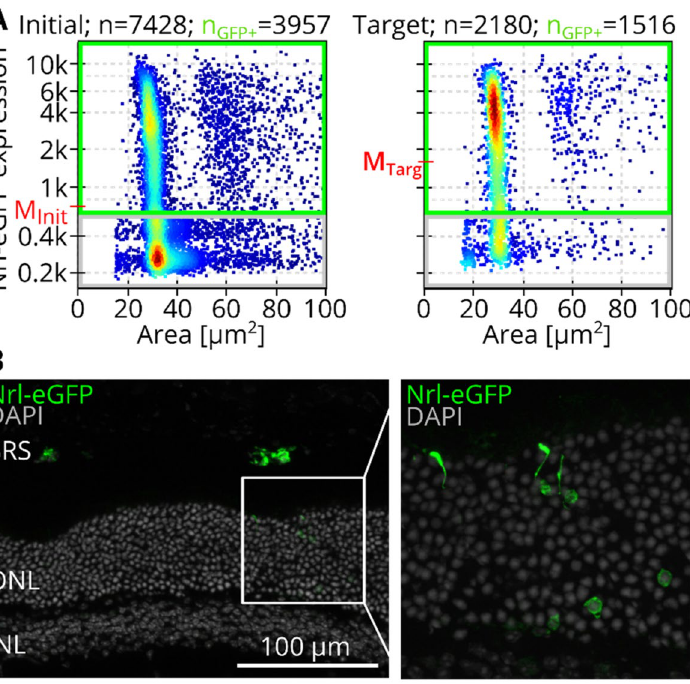
Figure 7. Label-free photoreceptor sorting of dissociated Nrl-eGFP mouse retina cells & transplantation. ( A ) Scatterplots show RT-FDC measurements of the initial sample and the target sample after label-free sorting. The axes show the area and fluorescence expression and the color code represents the density of events. The median fluorescence expressions are given as M Init (= 728) and M Targ (= 1,684). The gating strategy for selection of GFP + events is indicated by a green rectangle, resulting in 53.2% and 69.5% GFP + cells in the initial and target sample, respectively. ( B ) Immunofluorescence images showing sorted GFP + cells in the murine SRS, two weeks after transplantation. GFP + cell bodies and segments can be found in the host ONL (magnification), likely as a result of cytoplasmic material transfer from donor to host cells. SRS subretinal space, ONL outer nuclear layer, INL inner nuclear